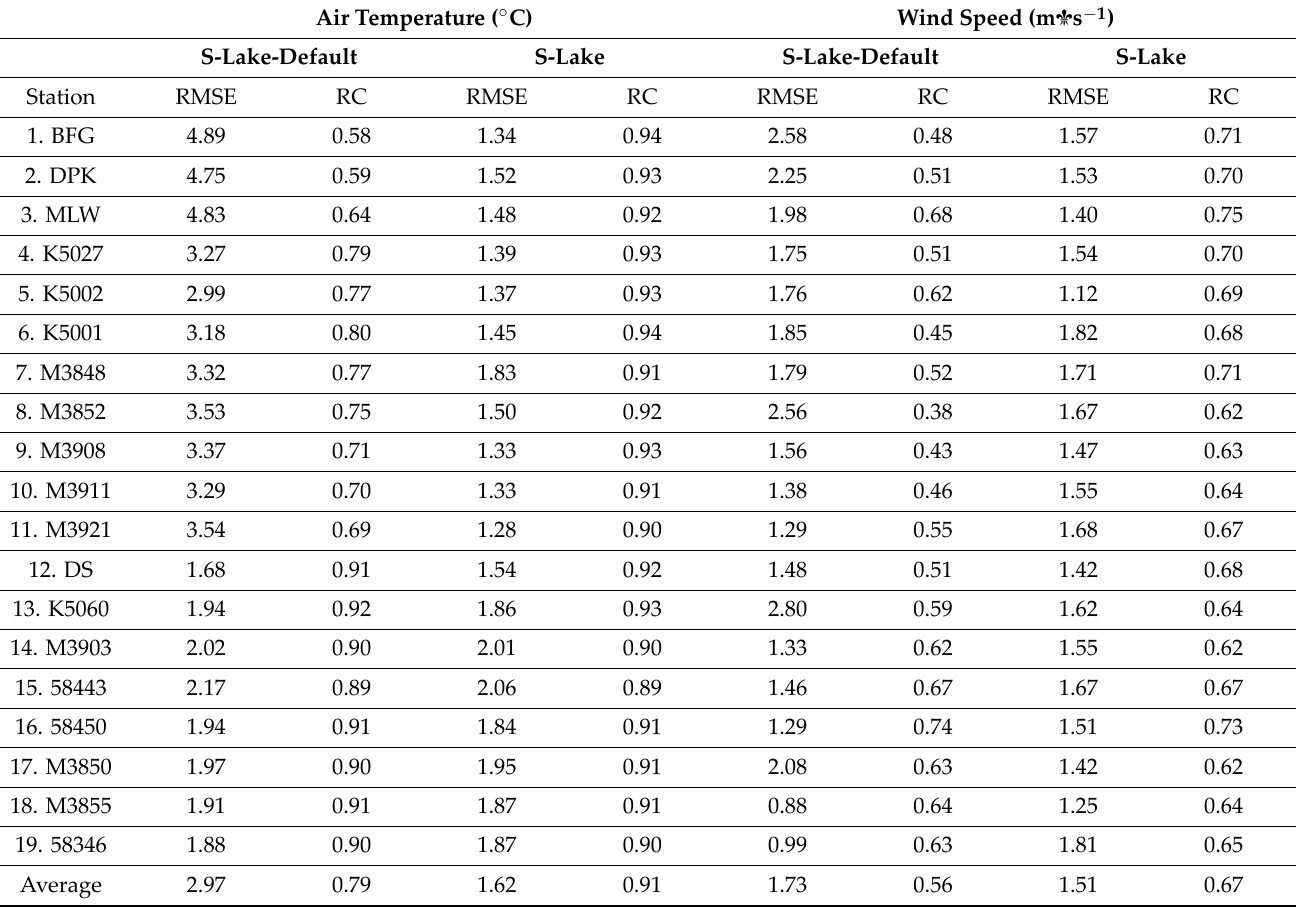
Table 3. Statistical indices (RMSE and RC) associated with hourly variables provided by the flux sites ( • ) in Figure 1. Observed and modeled skin temperature, sense heat flux and latent heat flux from 1 June to 31 August